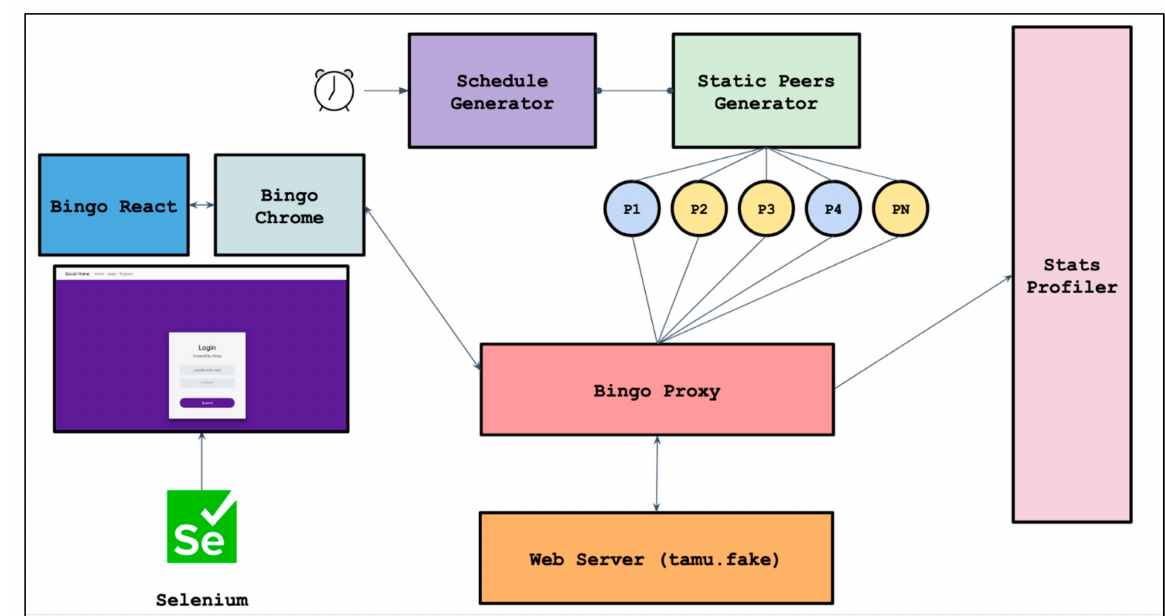
Figure 10. Test-bed used for running 24 simulated hours of logins.